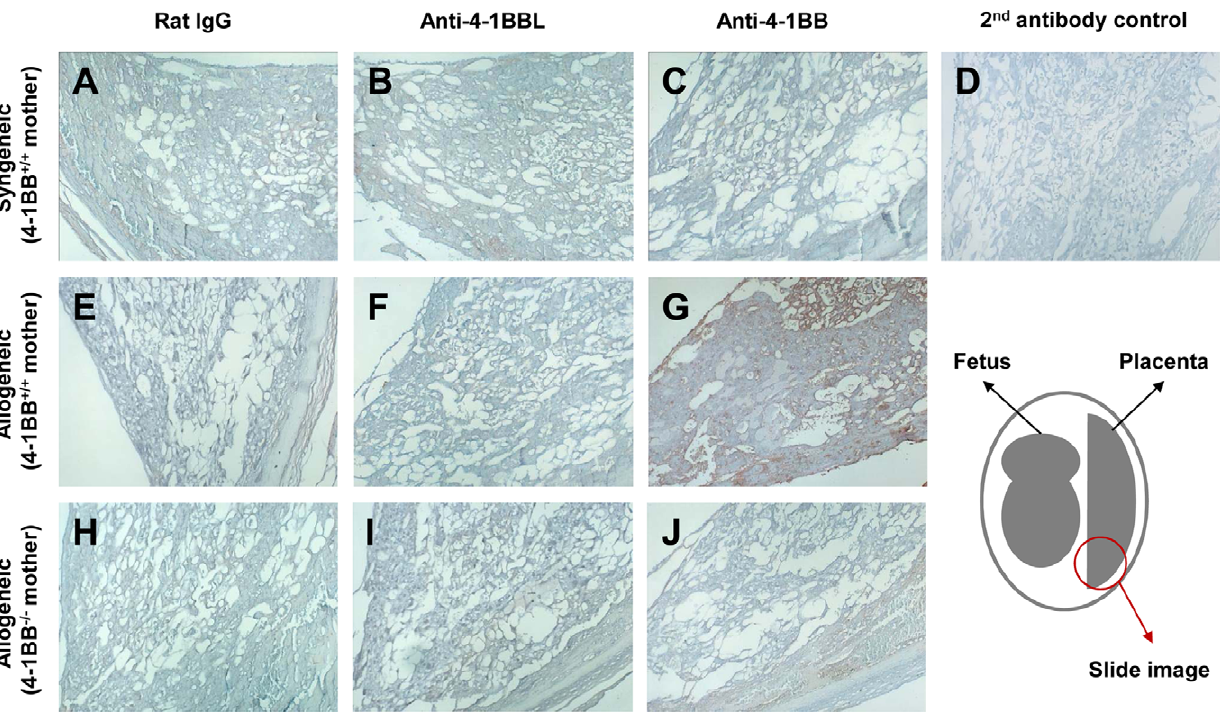
Figure 2. 4-1BB triggering leads to rejection of allogeneic fetuses. C57BL/6 females were time-mated with C57BL/6 (A-D) or DBA/2 male mice (E-G), while 4-1BB KO C57BL/6 females were time-mated with DBA/2 male mice (H-J) (n =5 per group). Female mice with vaginal plugs were separated into three groups and injected i.p. with 200 m g of rat IgG (A, E, H), blocking anti-4-1BBL (B, E, F) or agonistic anti-4-1BB mAb (C, G, J), at 8, 10, and 12 dpc. At 15 dpc, two or three pregnant mice were randomly selected from each group and three gravid uteri were collected from each pregnant mouse by avoiding dead fetuses. The gravid uteri were used to prepare paraffin blocks. Paraffin sections were stained with primary rabbit anti-human C3, followed by secondary HRP-conjugated anti-rabbit IgG. Bound antibody was detected with a Vector DAB substrate kit, and the sections were counterstained with hematoxylin. Paraffin secions were stained with secondary HRP-conjugated anti-rabbit IgG alone as a negative control (D). Original magnification 6 20. Data are representative of two independent